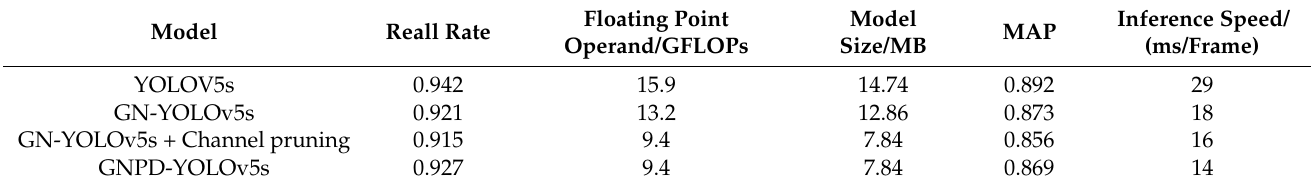
Table 3. Ablation experiment.